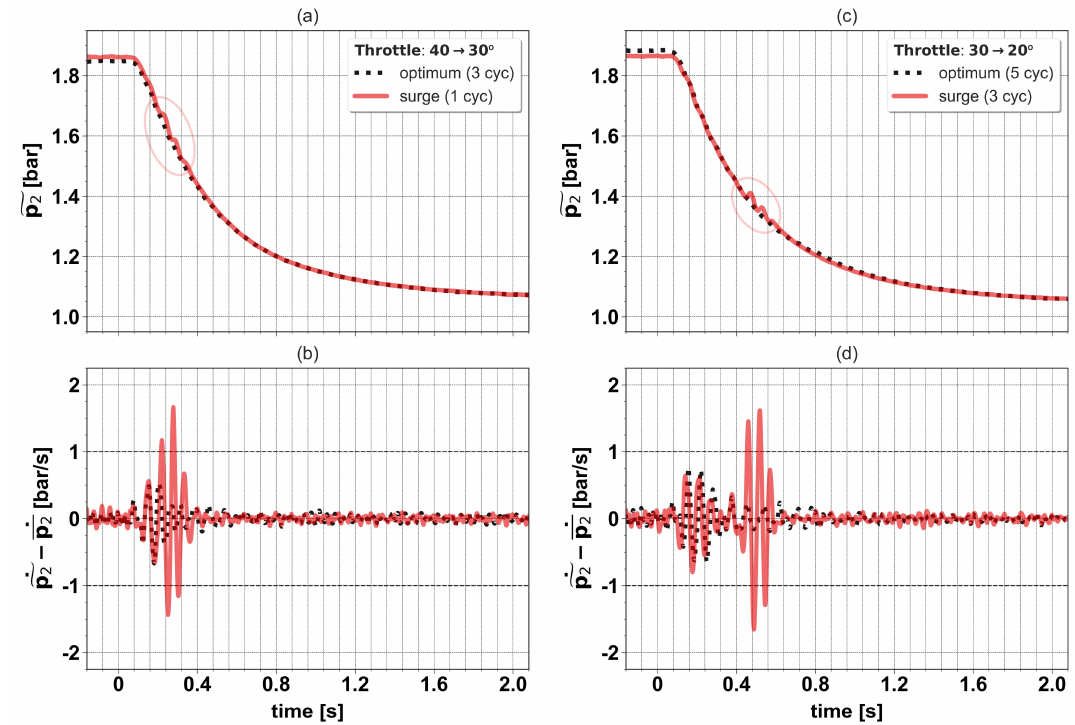
Figure 3. Time evolution of compressor outlet pressure and its time derivative for two cases of the transitions 40–30 ◦ ( a , b ) and 30–20 ◦ ( c , d ). In the insets, the duration of the transition is stated between